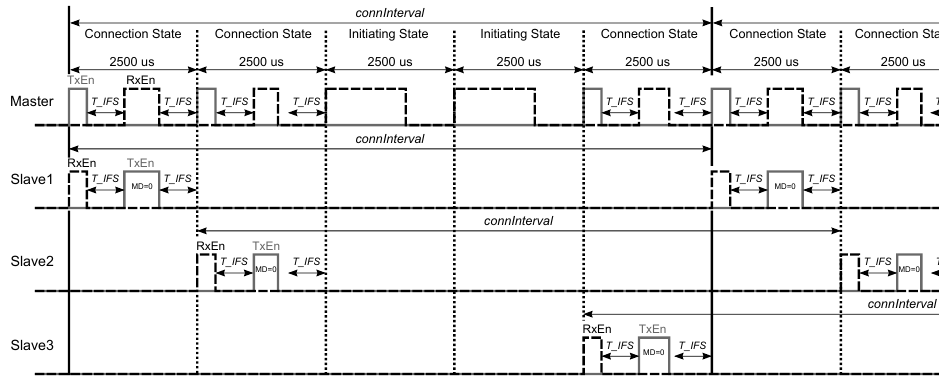
Figure 9. An example of timing diagrams of the master device in the multiple slaves mode—the connection interval is subdivided into 5 subintervals with the first, the second and the fifth subintervals used for one connection event between the master and the slaves 1, 2 and 3, respectively, while the third and the fourth subintervals are used for listening for new advertisements.